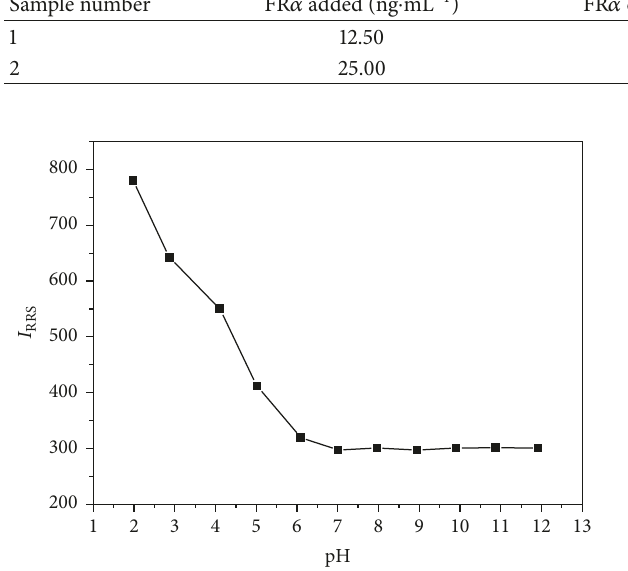
Figure 4: Effect of antibody concentration on the modification of Au NPs with anti-FR 𝛼 antibody. Concentrations: Au NPs, 3.0 nM; pH, 7.00; NaCl, 0.67%; anti-FR 𝛼 ( 𝜇 g ⋅ mL −1 ), 0.10, 0.20, 0.30, 0.40, 0.50, 0.60, and